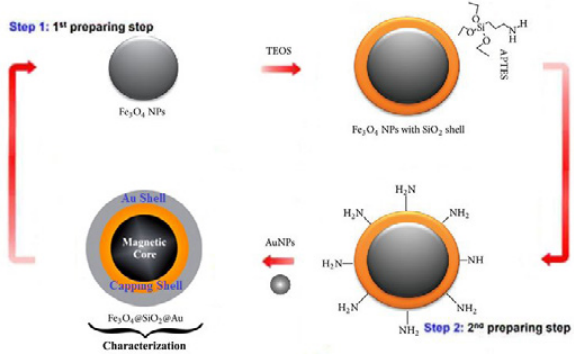
Fig. 2. Step 1: An illustration of the Fe